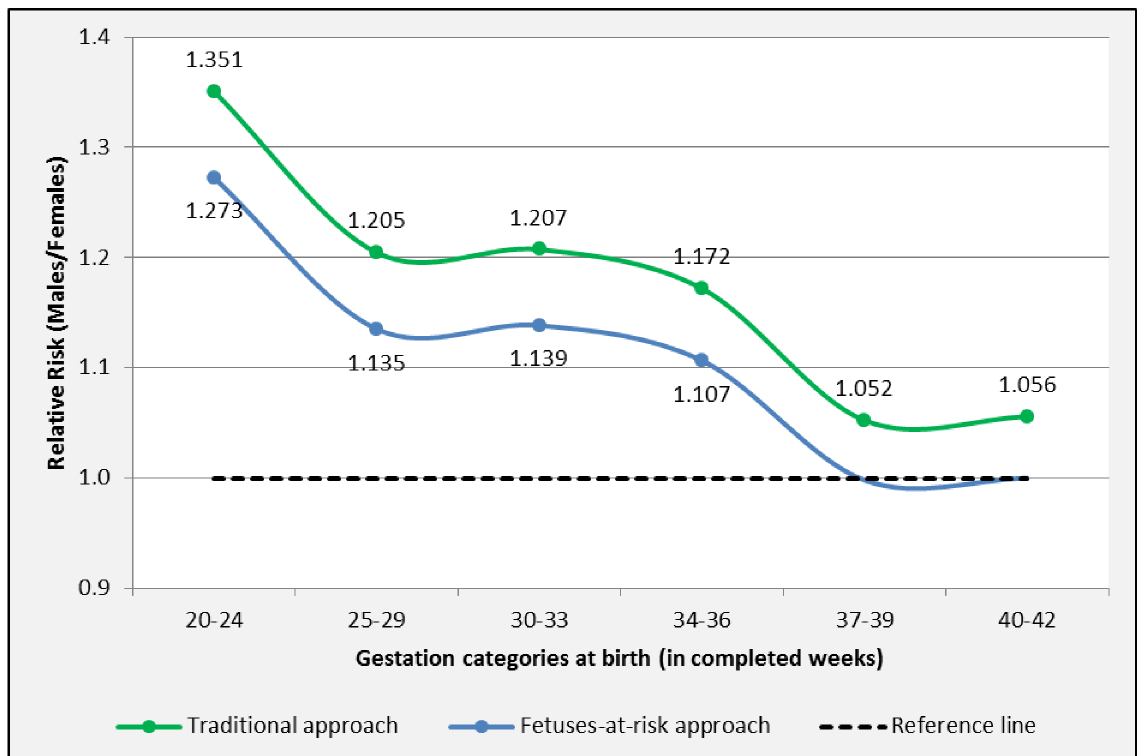
Fig 2. Sexual dimorphism for length of gestation in categories. Births in South Australia 1981 – 2011. Marked points represent significant RR M/F.